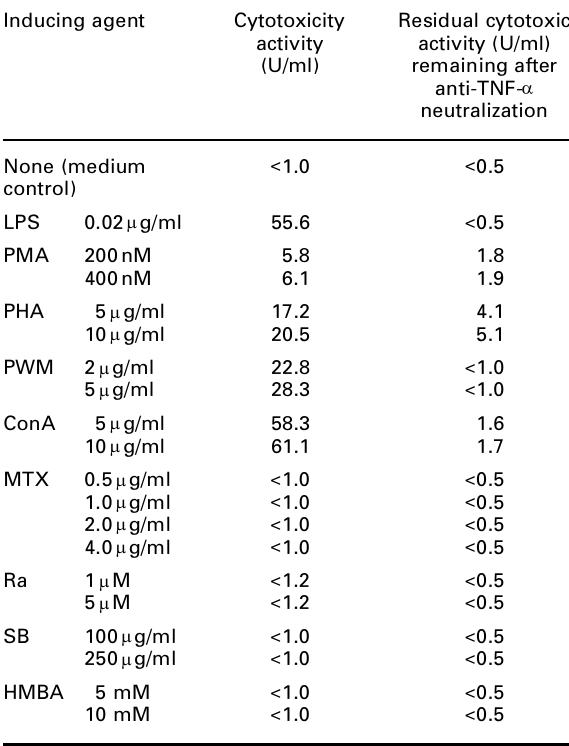
Table 3. Residual TNF-like cytotoxicity in AMC supernatants with anti-TNF- a monoclonal antibody neutralization Inducing